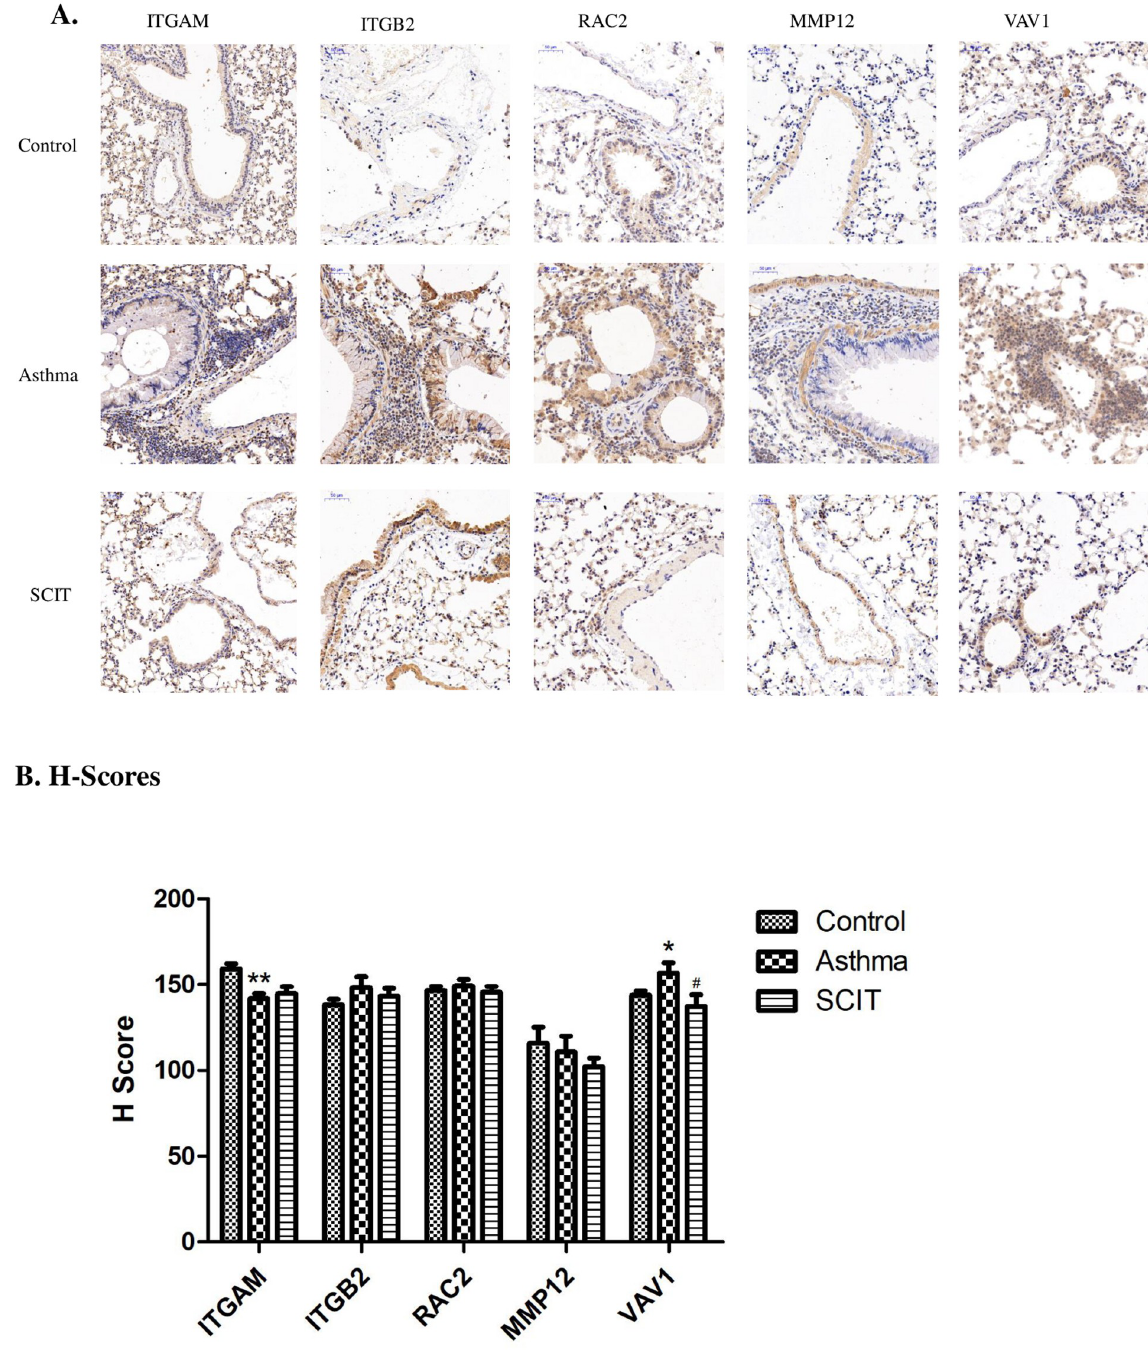
Fig 7. IHC results. A. IHC exhibited the expression of proteins in the leukocyte extravasation signaling pathway on formalin-fixed and paraffin-embedded mice lung tissues. Original magnification, × 200. B. H-scores representing IHC results were shown in the section. The histogram was shown as means ± SD, �� represented the asthma group vs. the control group, P < 0.01; � represented the asthma group vs. the control group, P < 0.05; # represented the asthma group vs. the SCIT group, P < 0.05.